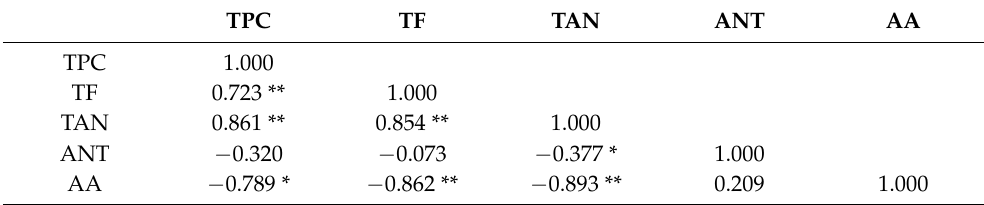
Table 3. Pearson’s correlation coefficient ( r ) and the related significance between the total phenolic compounds (TPC), total flavonoids (TF), tannins (TAN), anthocyanins (ANT), and antioxidant activity (AA, IC 50 ). TPC TF TAN ANT AA TPC 1.000 TF 0.723 ** 1.000 TAN 0.861 ** 0.854 ** 1.000 ANT − 0.320 − 0.073 − 0.377 * 1.000 AA − 0.789 * − 0.862 ** − 0.893 ** 0.209